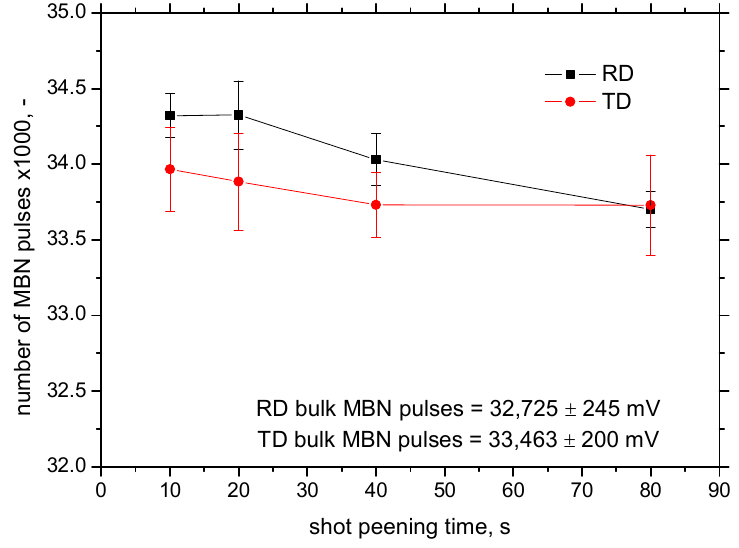
Figure 10. Number of detected MBN pulses.